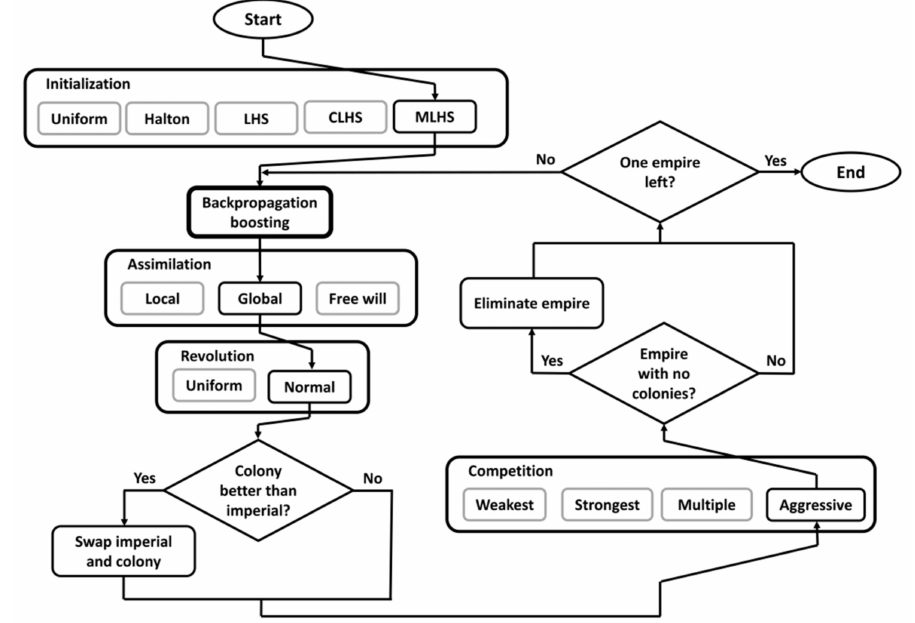
Figure 2. Diagram illustrating the steps of our algorithm: The country population was initialized using Maximin Latin Hypercube Sampling, an approach chosen out of several others. Then, at the start of each ICA iteration, backpropagation boosting was applied in order to steer the solutions toward the optimum. The main loop largely followed the same progression as the traditional ICA; however, the fundamental steps (assimilation, revolution, competition) were chosen out of several possible versions. The choices were made following an analysis to determine the steps that best suited our algorithm in terms of effectiveness, considering the problem described in Section